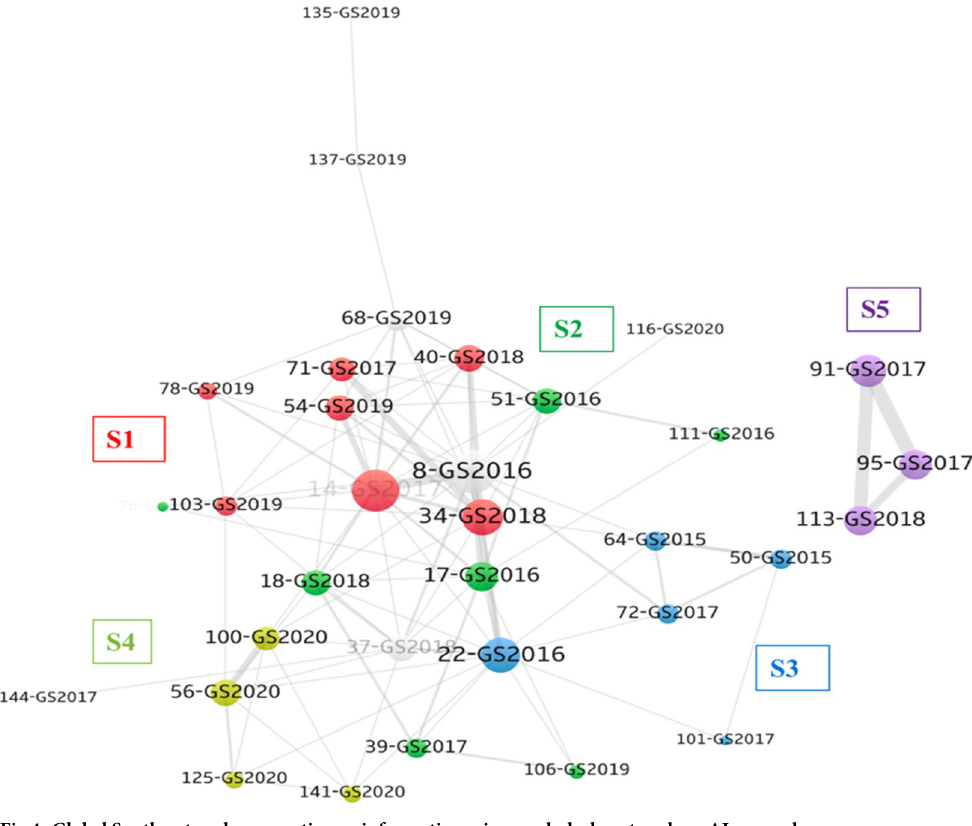
Fig 4. Global South network perspective on information science scholarly network on AI research.